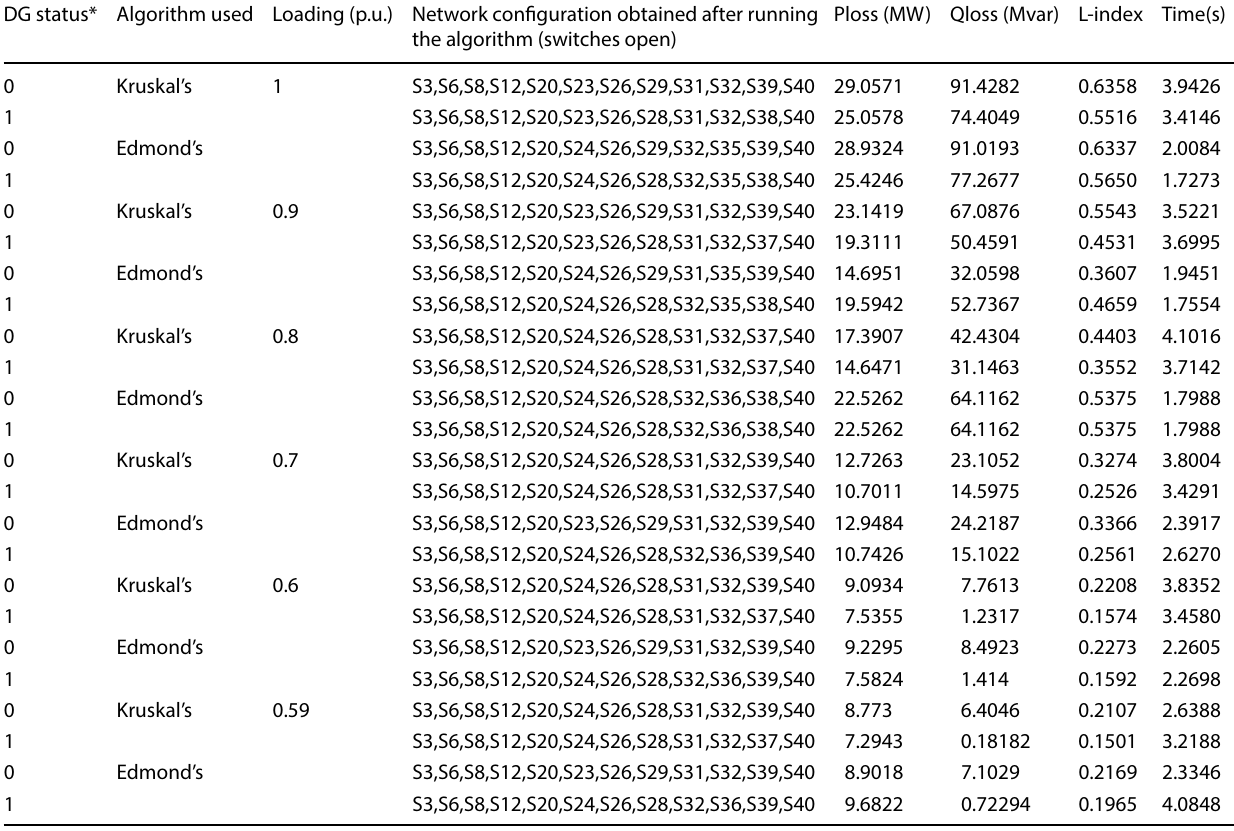
*Where, 0 = network without DG, and 1 = network with